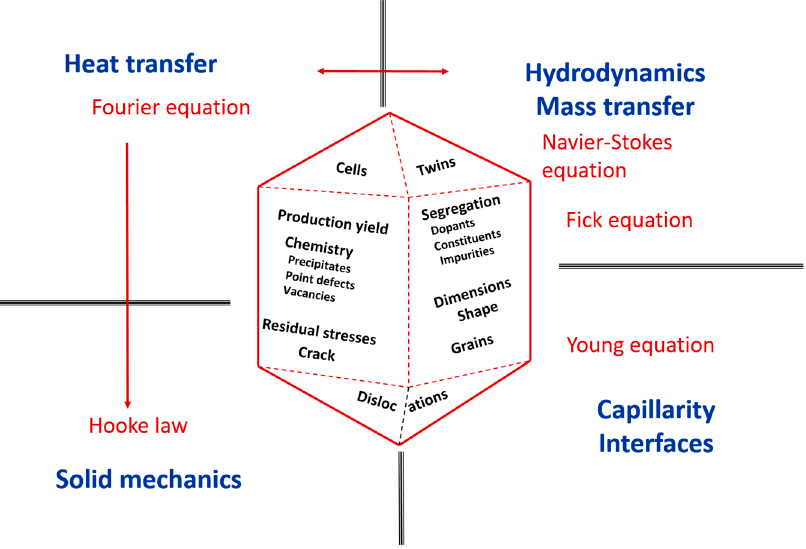
Figure 2. Fundamental physical phenomena impacting the occurrence of defects in a crystal.